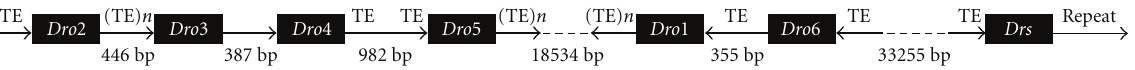
Figure 5: The distribution of TEs and the repetitive sequence in the flanking regions of drosomycin family in D. melanogaster . ORFs of drosomycins were indicated by black squares and the transcription directions were indicated by arrows. Number below the arrows indicated the intergenic length. The location of TEs and repetitive sequence was marked above the arrows. (TE) n meant that there was more than one TE in the